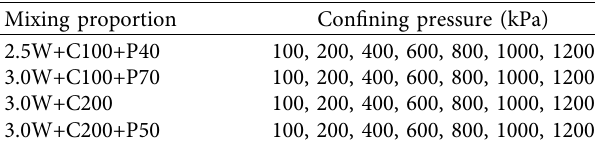
Figure 3: Phosphogypsum. Table 2: Programme of triaxial